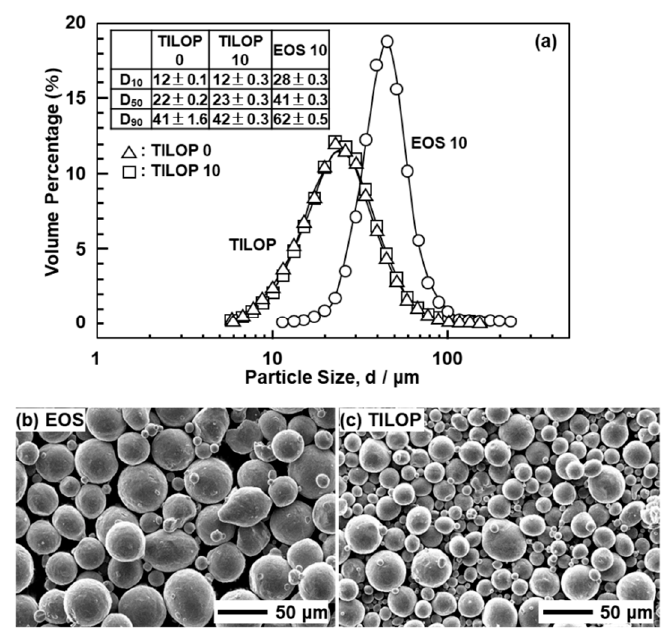
Figure 2. ( a ) Particle size distributions of 10-times-sintered EOS (EOS 10) and once-sintered (TILOP 0) and 10-times-sintered TILOP (TILOP 10) commercially pure (CP) Ti G 2 powders; SEM images of ( b ) 10-times-sintered EOS and ( c ) TILOP CP Ti G 2 powders.